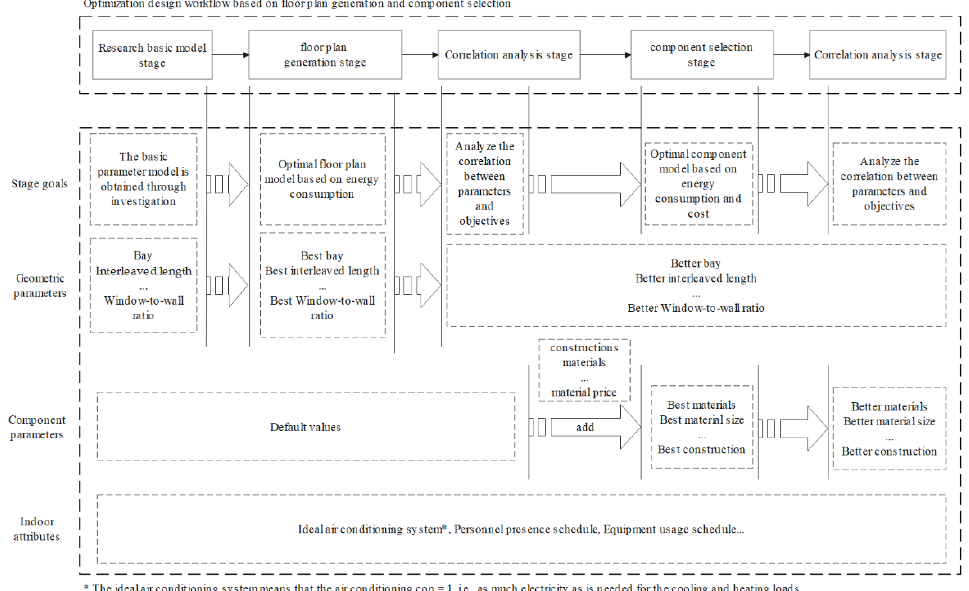
Figure 5. Goals, parameters, and attributes of the different phases of the floor plan generation and component selection methods.